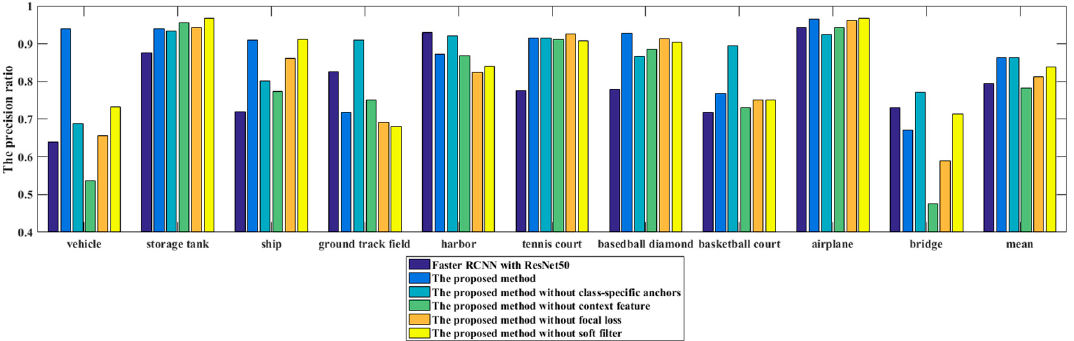
Remote Sens. 2019 , 11 , x FOR PEER REVIEW 19 of 24